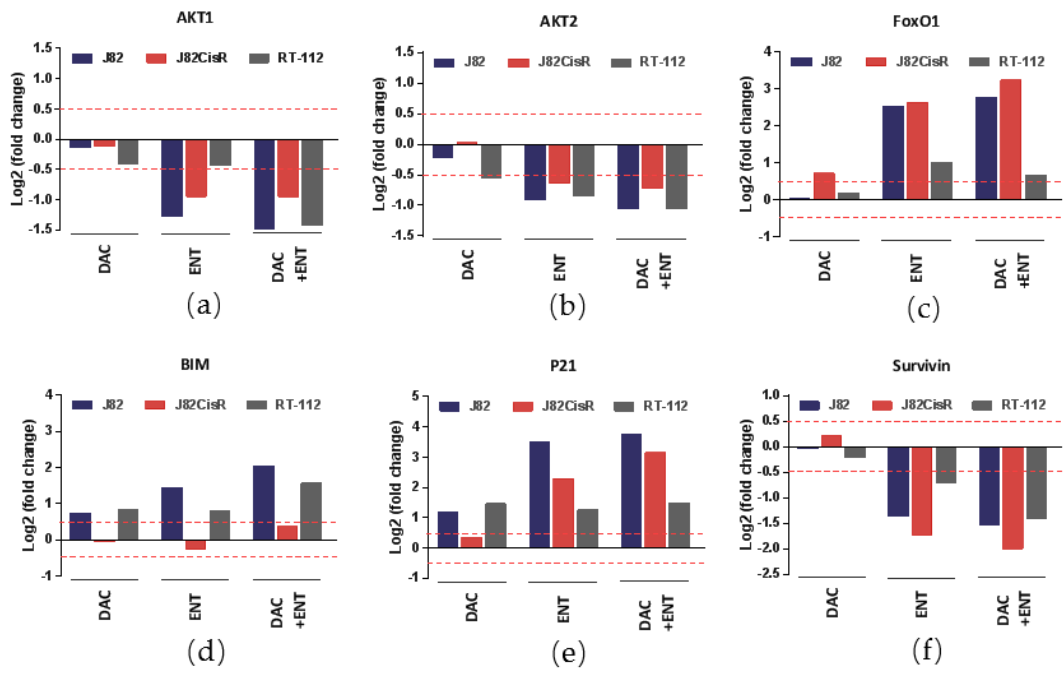
Figure 5. Epigenetic treatments alter gene expression in urothelial bladder cancer cell lines. ( a – f ) DAC and ENT resulted in the changes of genes involved in Akt / FoxO pathway. Data shown are RPKM (reads per kilobase per million mapped reads) values normalized from three independent RNA-seq experiments; x axis indicates treatment conditions; y axis indicates log2 fold change of RPKM compared with untreated control.